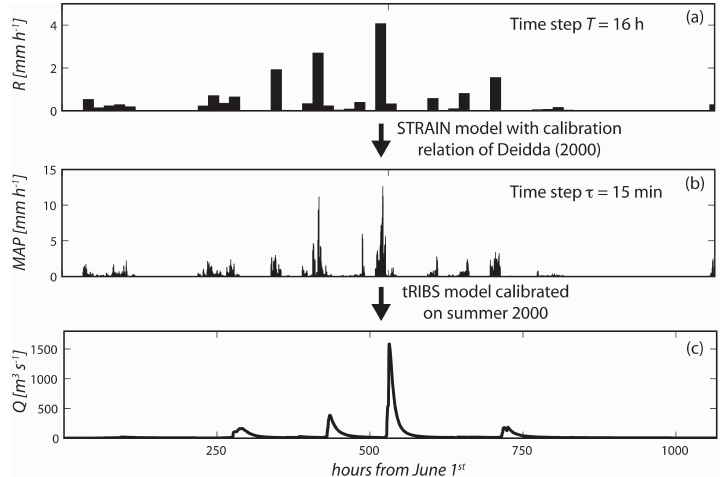
Fig. 2. Synthetic “observed” database generation. (a) Time series of NEXRAD rainfall estimates R during summer 2000, aggregated in the coarse spatial domain L × L (with L =256km) centered on the Baron Fork over an accumulation time T =16h. (b) Time series of Mean Areal Precipitation (MAP) over Baron Fork, calculated by averaging the high-resolution (4-km, 15-min) “observed” rainfall fields, obtained by downscaling the coarse rainfall R with the STRAIN model. (c) Time series of the “observed” hydrograph at the Baron Fork outlet, produced by the tRIBS model with the “observed” fine-scale rainfall forcing. Table 1. Baron Fork sub-basin characteristics (Vivoni et al., 2006): area ( A ), maximum distance to the sub-basin outlet ( L ), relief ratio ( S ), drainage density ( D d ); time of concentration ( T c ) from Kirpich (1940): T c =0.000325 × L 0 . 77 × S − 0 . 385 , where units are L [m] and S